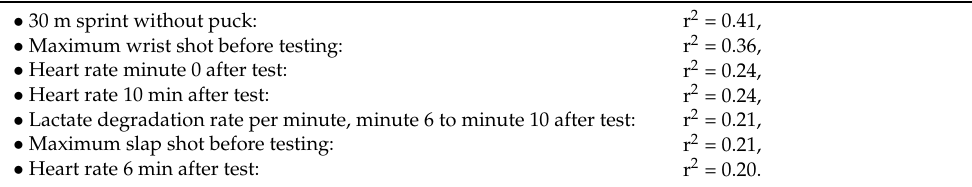
Table 4. All IHCT parameters with r 2 ≥ 0.20 according to the MPS.